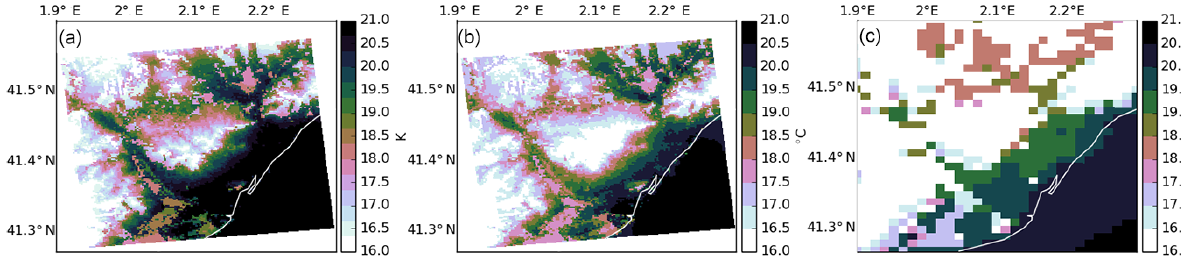
Figure 7. Daily minimum temperature averaged over the period May–September 2011 in (a) UC-ERA, (b) UC-FC and (c) WRF.